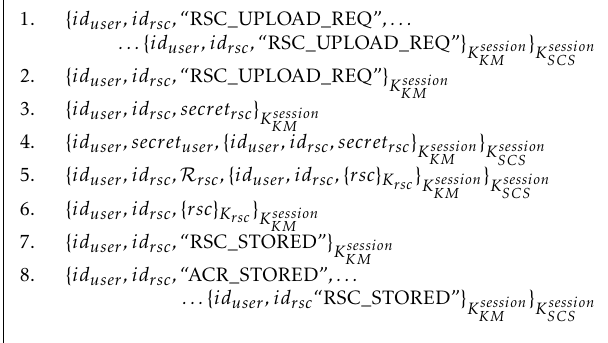
Figure 10. Resource upload phase: messages